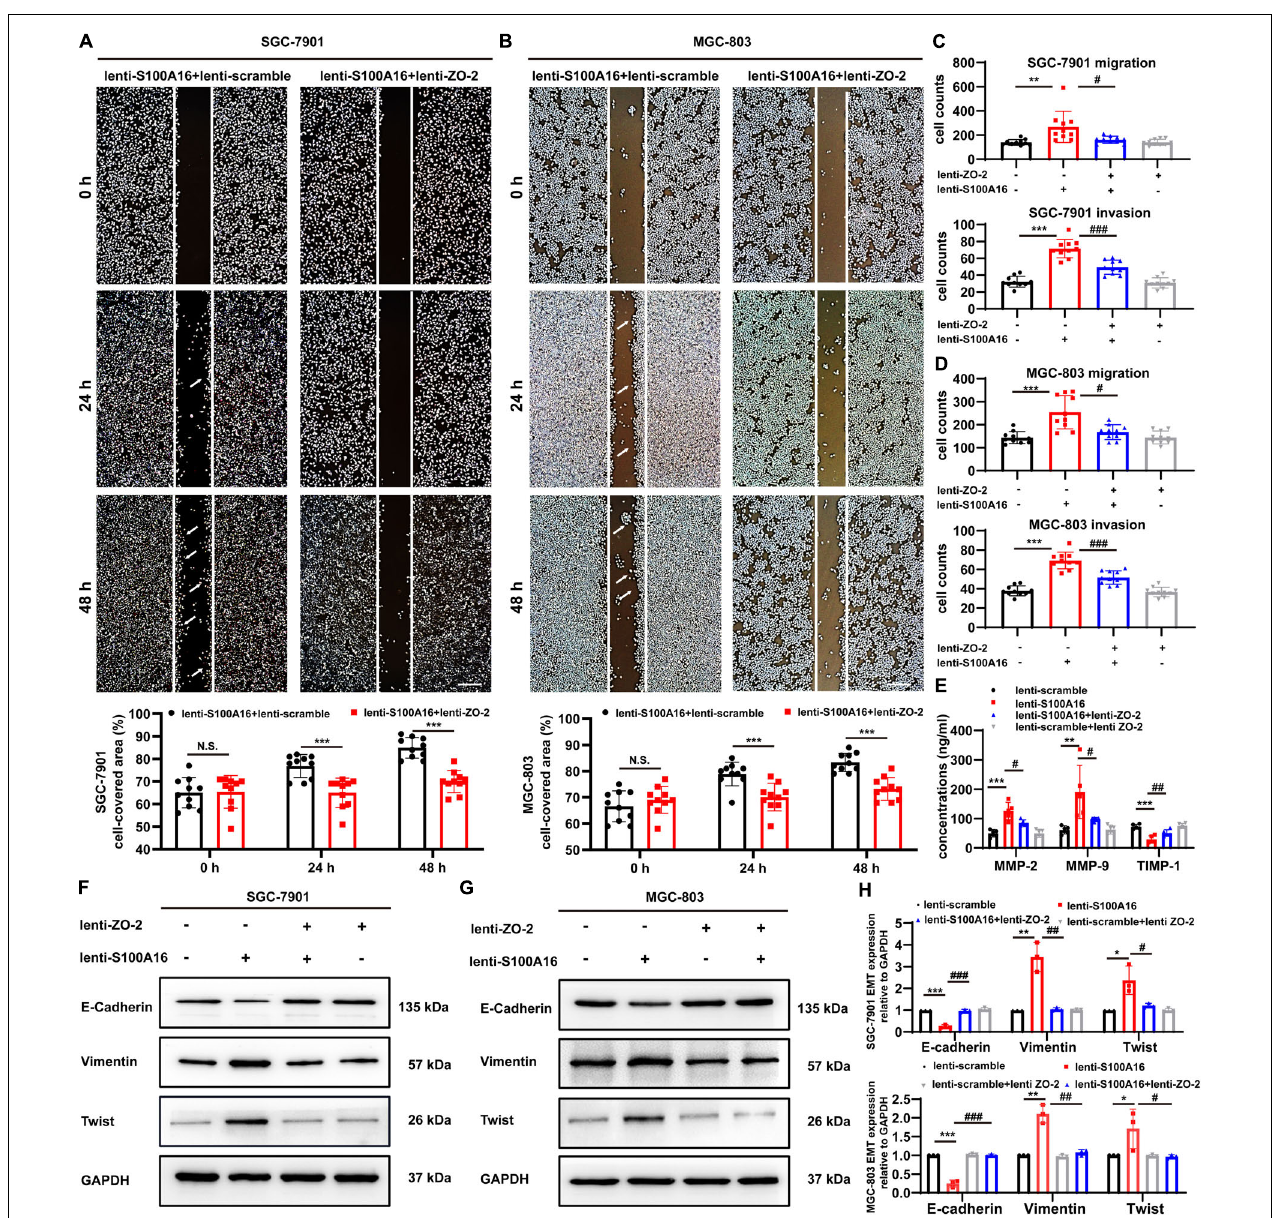
FIGURE 7 | S100A16 triggers the process of invasion, migration and EMT in GC cells via ZO-2 inhibition. (A,B) The scratch wound-healing assays of SGC-7901 (A) and MGC-803 cells (B) stably overexpressing S100A16/ZO-2 or singly S100A16. Quantitative analysis was done below. Scare bar = 100 µ m. (C,D) SGC-7901 (C) and MGC-803 cells (D) migration and invasion were measured by transwell assays. Cells were quantified. (E) MMP-2, 9 and TIMP-1 levels in culture supernatant of SGC-7901 cells were measured by ELISA assays. (F–H) The protein levels of EMT markers (E-Cadherin, Vimentin and Twist) in SGC-7901 (F) and MGC-803 cells (G) . GAPDH was used as internal standard. Gray density was quantified in panel (H) . Data are presented as mean ± SD. N = 3-10 for each group. For panels (A,B) , * P < 0.05, ** P < 0.01, and *** P < 0.001 vs. lenti-S100A16 + lenti-scramble group. For panels (C–E,H) , * P < 0.05, ** P < 0.01, and *** P < 0.001 vs. lenti-scramble group, # P < 0.05, ## P < 0.01, and ### P < 0.001 vs. lenti-S100A16